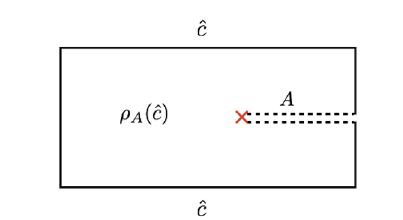
Figure 2 . Euclidean path-integral for the reduced density matrix (cid:26) A (^ c ) from a particular chaotic